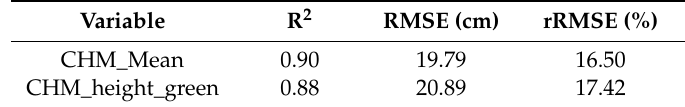
Table 2. The comparison results between vegetation height models from all 75 samples.